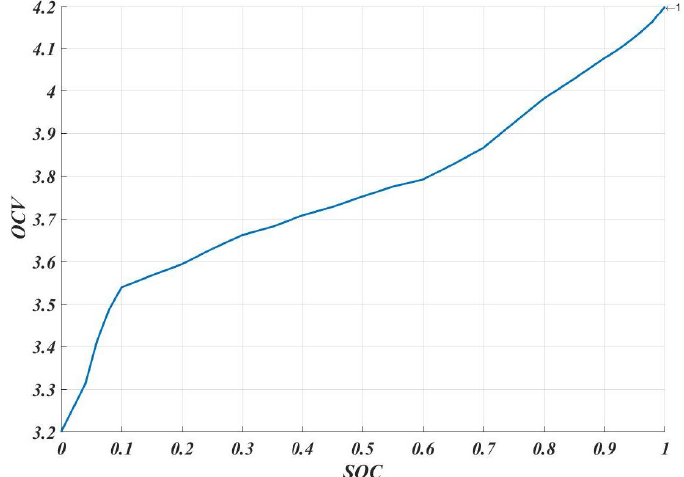
Figure 6. OCV vs. SOC for NASA dataset.